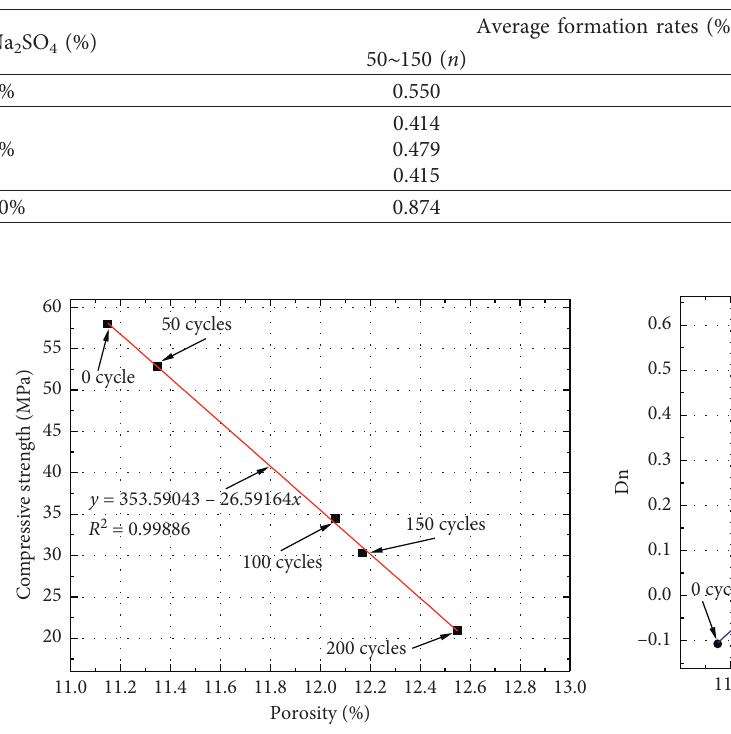
Figure 12: Cumulative pore volume of concrete during coupling cycle. Table 8: Average formation rates of corrosion products during freeze-thaw cycles.